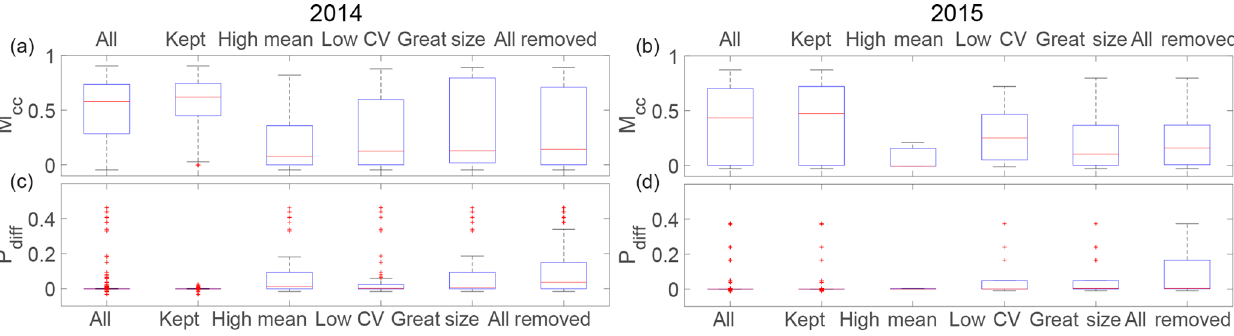
Figure 8. (a) Box plot of Matthews correlation coefficient, Mcc, when Mcc (cid:54)= 0 and Mcc (cid:54)= 1 and (b) positive difference percentage, P diff , when Mcc = 0 (no matched pixel) for all images, for the images kept, and for the images removed from the high-intensity mean, low-intensity coefficient of variation (CV) or size thresholds.